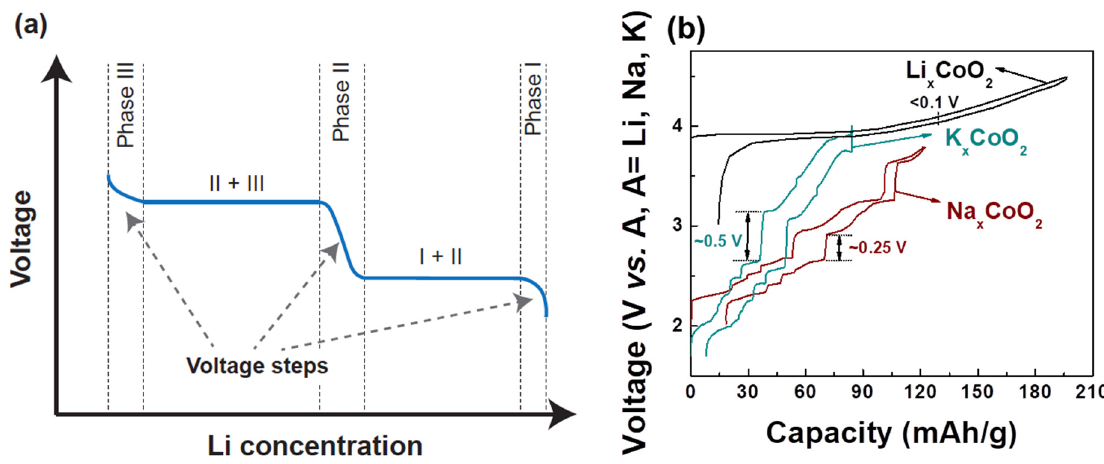
Figure 2. ( a ) Typical charge–discharge of intercalation-based cathode materials. A voltage step indicates new phase formation. ( b ) Charge–discharge comparison of O3-Li x CoO 2 , P2-Na x CoO 2 , and P2-K x CoO 2 [44,47,48]. Voltage curves for P2-Na x CoO 2 , P2-K x CoO 2 , and O3-Li x CoO 2 are reproduced with permissions from [44,47,48]. The voltage curve for P2-K x CoO 2 is licensed under CC BY-NC 4.0 [47].